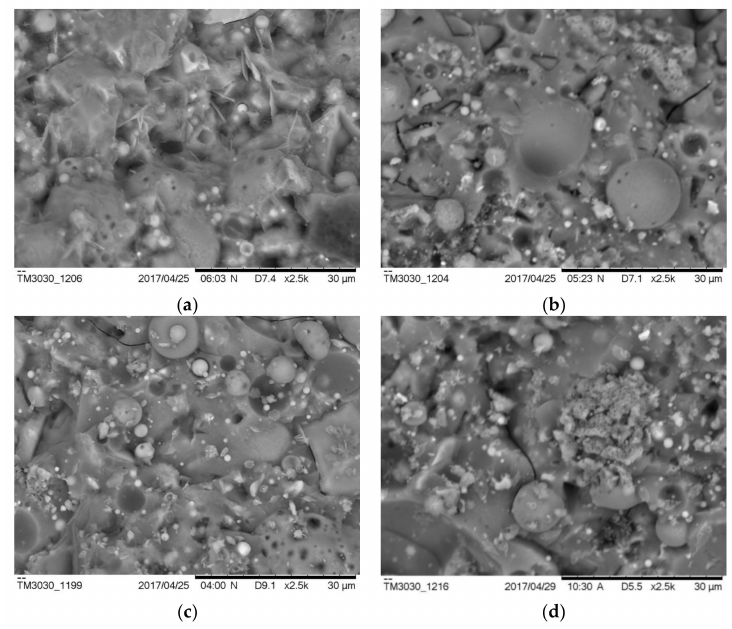
Figure 11. The microstructure of the AAFS pastes with the activator modulus of 0 ( a ), 1.0 ( b ), 1.5 ( c ), and 2.0 ( d ) at 7 days (the slag content is 30 wt %).